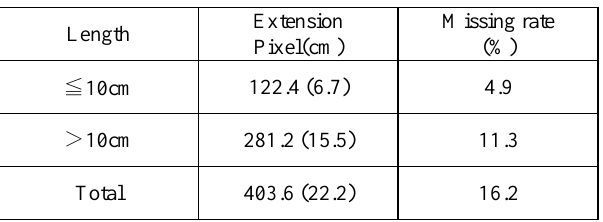
Table 5. List of missing